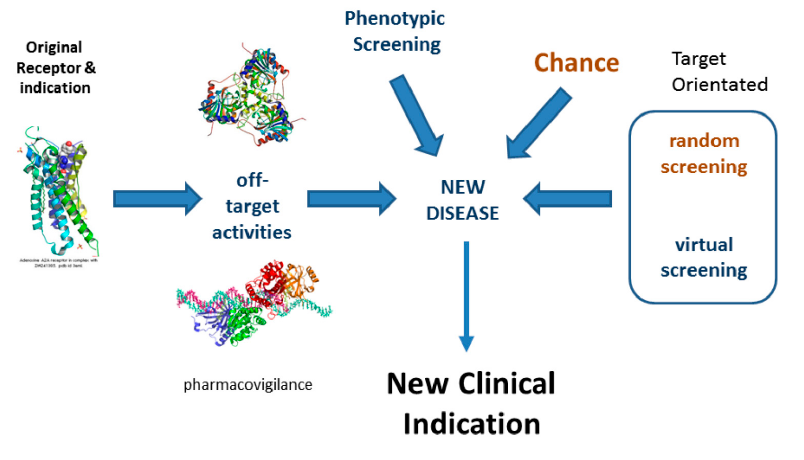
Figure 2. Drug repositioning.